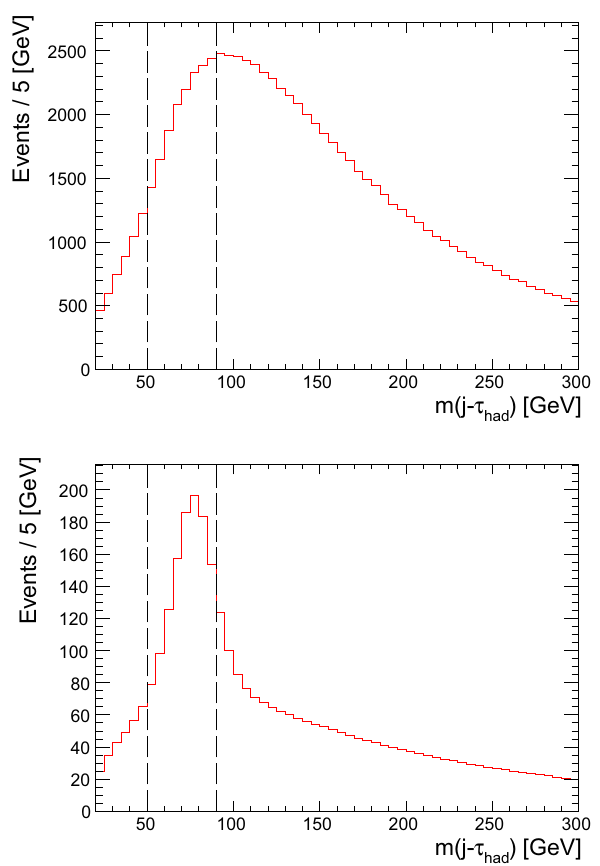
Fig. 3 The distribution of m ( j − τ had ) in the tt → bb (cid:2)τ had candidate event sample. The event selection requirement on this quantity has not been applied. The upper plot shows events in which the τ had candidate originates from a genuine τ decay and the lower plot shows events in which the τ had candidate originates from a misidentified hadronic